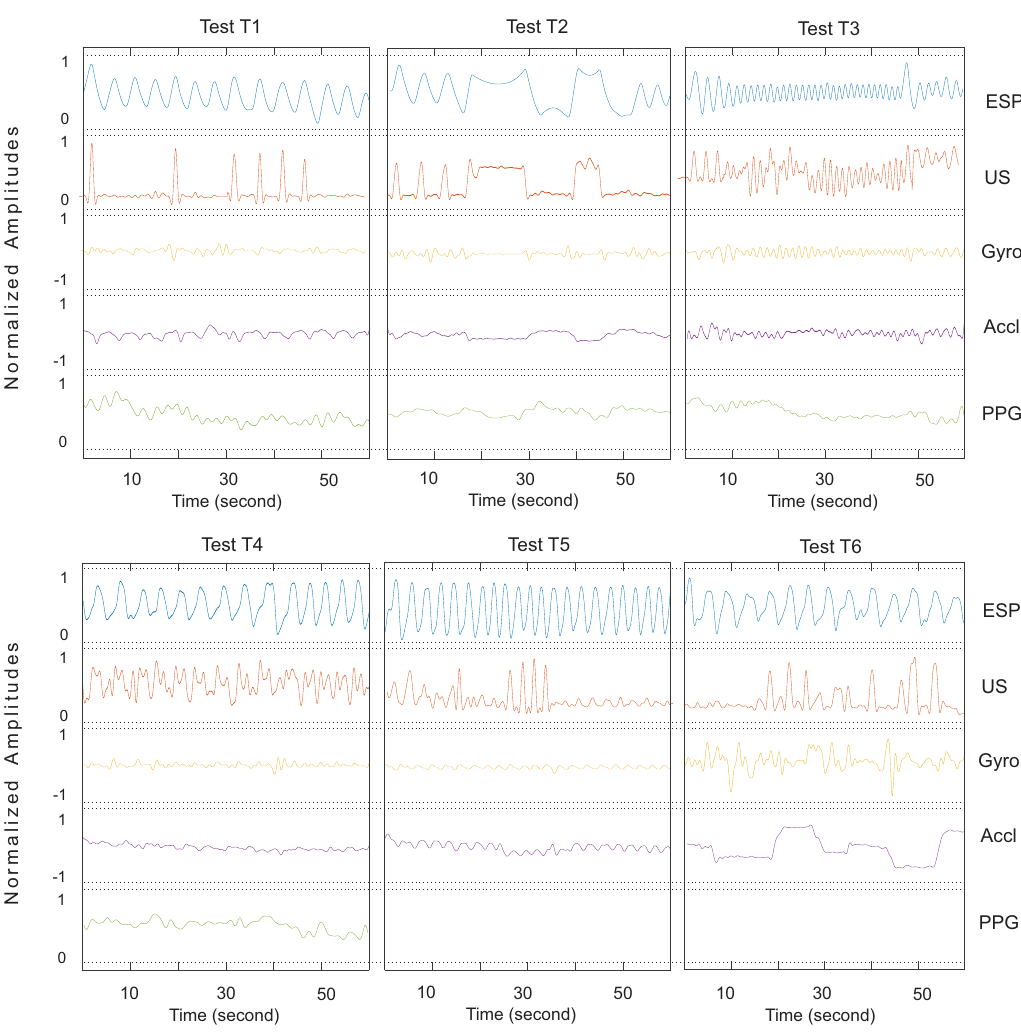
Figure A3. Respiratory waveforms of Subject